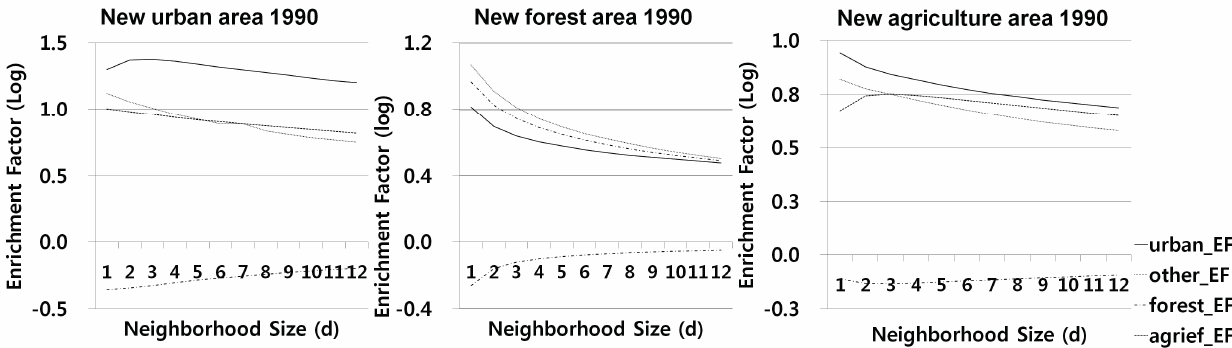
Figure 5. Enrichment factors (EF) of land-use changes between 1980 and